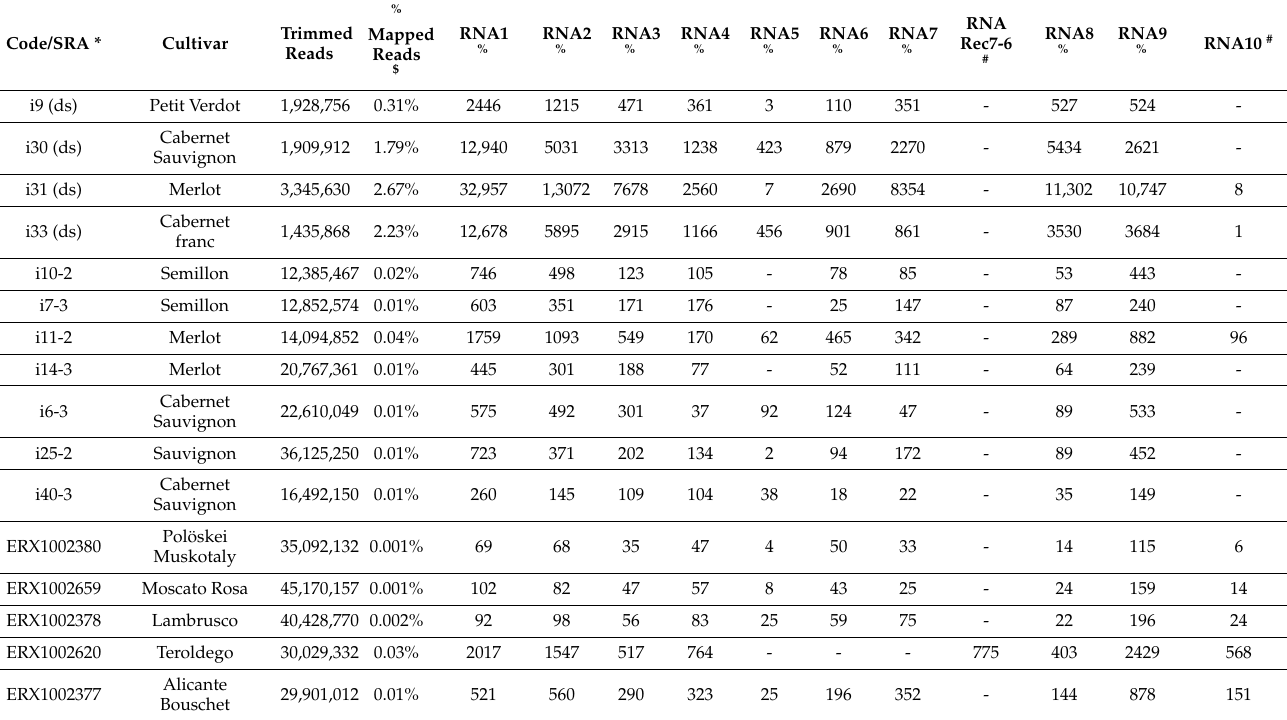
Table 1. Mapping of reads from various grapevine HTS datasets on the GaJV-1 genomic